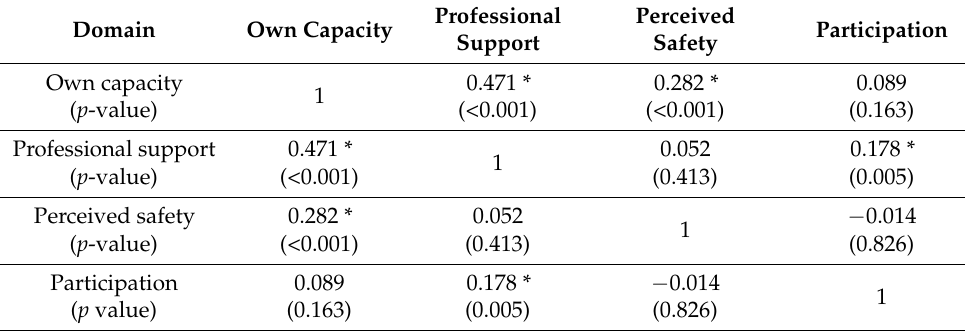
Table 6. Inter-scale correlations between the CEQ-My